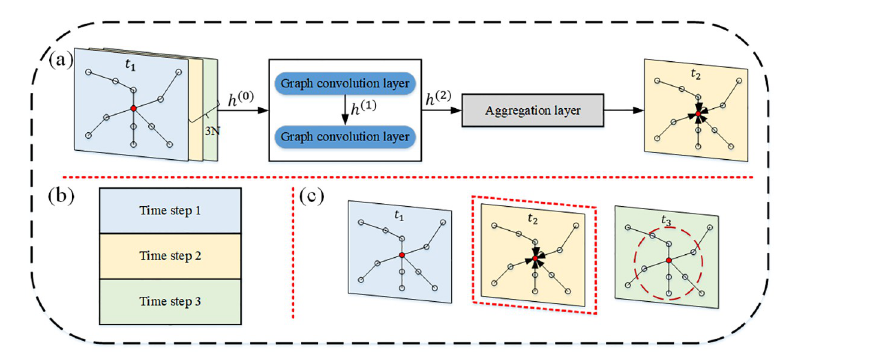
Fig 6. STSGCM architecture. (a) STSGCM; (b) Aggregation operation; (c) Cropping